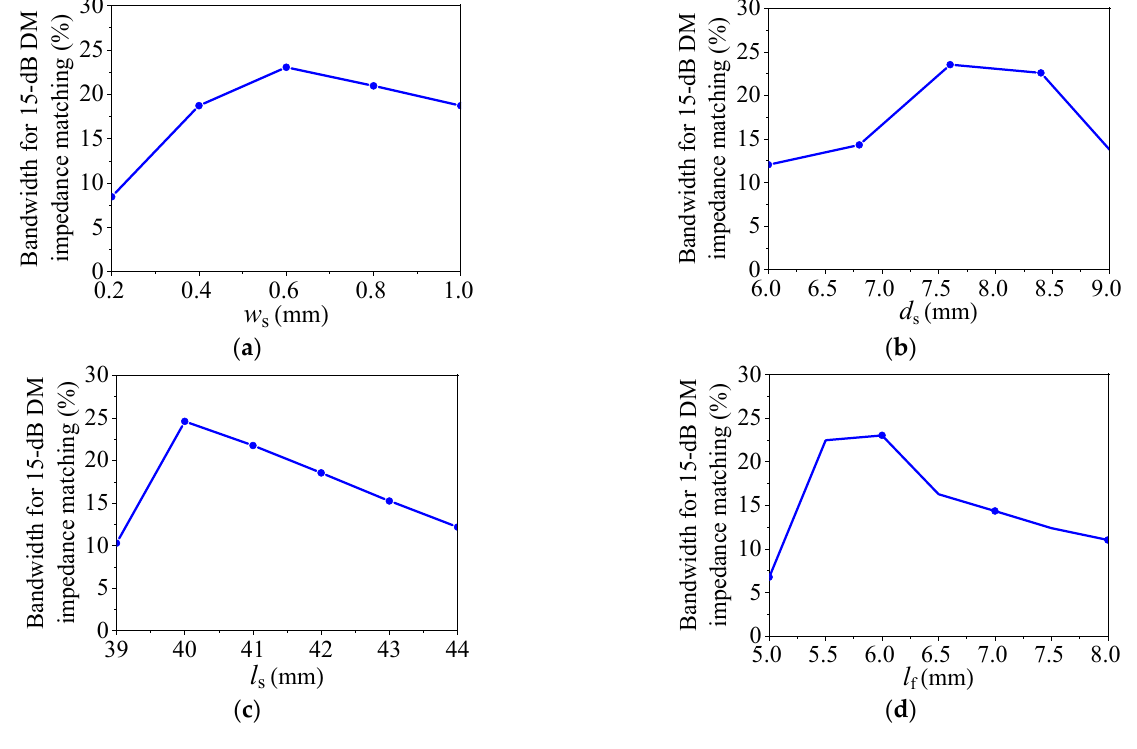
Figure 5. The simulated bandwidth for 15-dB DM impedance matching of the proposed balanced SIW phase shifter with different w s , d s , l s , and l f . ( a ) With different w s . ( b ) With different d s . ( c ) With different l s . ( d ) With different l f .